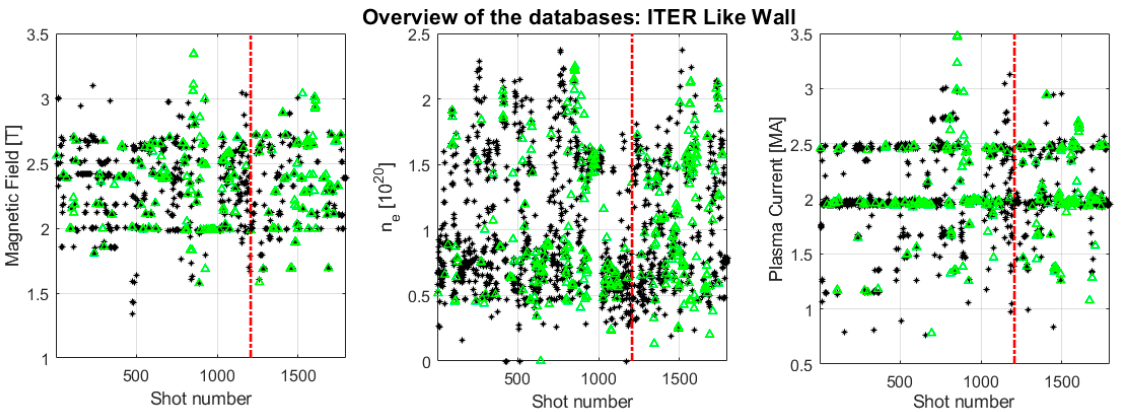
Figure 4. Overview of the database. Green triangles: disruptive examples. Black asterisks: safe discharges. The vertical line indicates the beginning of C31, the campaign used as test setT